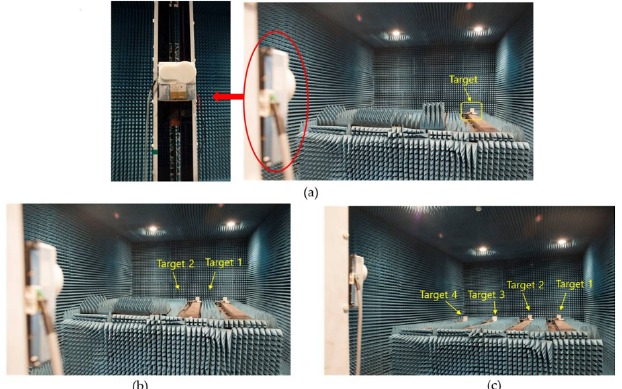
Figure 7. Experiment scenarios. ( a ) L-shaped radar module and scenario of one target; ( b ) Scenario of two targets; ( c ) Scenario of four